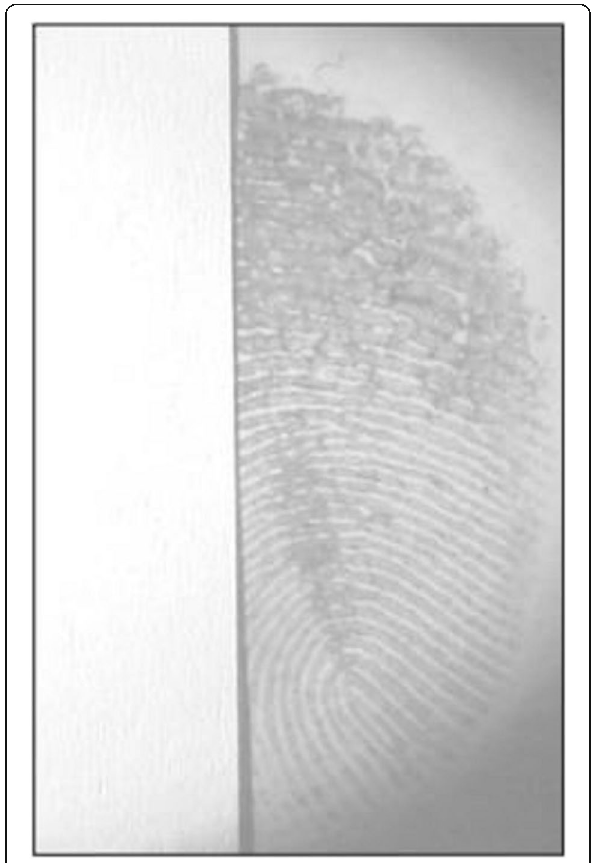
Fig. 2 Example of fingerprints on thermal paper developed with LED torch (adapted from Bond (2015b))